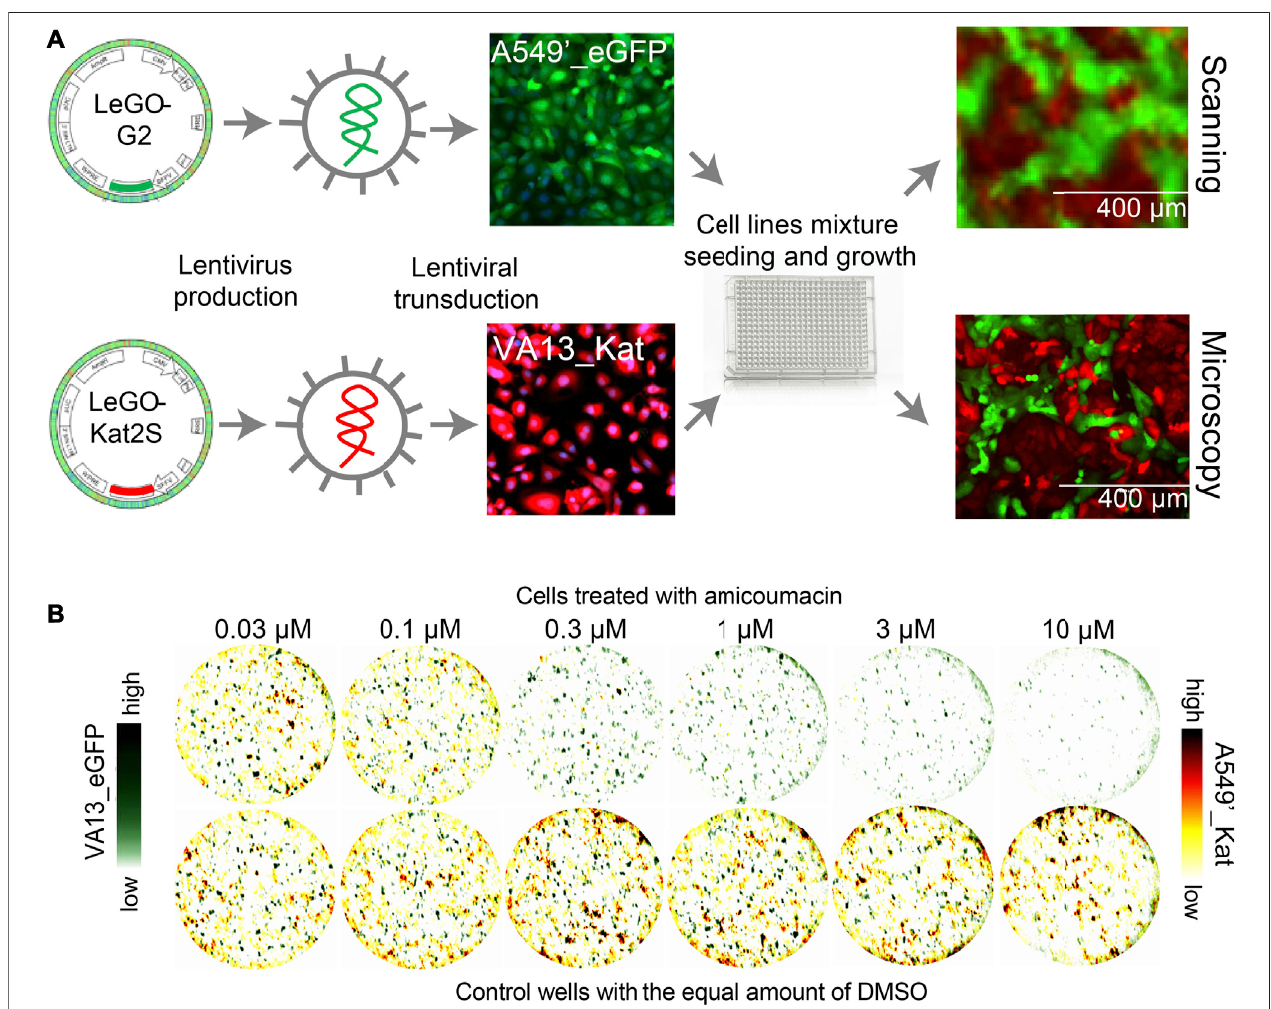
FIGURE1| Preparation andimagingof fl uorescent celllines A549 ’ _EGFP/VA13_Kat and VA13_EGFP/A549 ’ _mCherry. (A) Theschemeoflabeling ofthecelllines bylentiviralintegrationof fl uorescentproteingeneswithexamplesofA549 ’ _EGFP/VA13_Katcells. (B) ImagesofmixedcultureofA549 ’ _EGFP/VA13_Katcellsobtained by scanning at a resolution of 10 µm (top) and by microscopy (bottom) . (C) . Images of the coculture of VA13 and A549 ′ derivative cell lines VA13_EGFP j A549 ’ _mCherry. The images were obtained by superimposing scanned data in the channels of red and green fl uorescent proteins. The upper row of imaged wells was treated with a series of dilutions of the known selective compound amicoumacin. VA13 cells (green channel) are alive much more than A549 ′ tumor cells at a concentrationofamicumacin of0.3 – 3 µM.Asareference,atthe bottom row,therearedemonstrated cellstowhichDMSO(drugsolvent) wasaddedat theappropriate